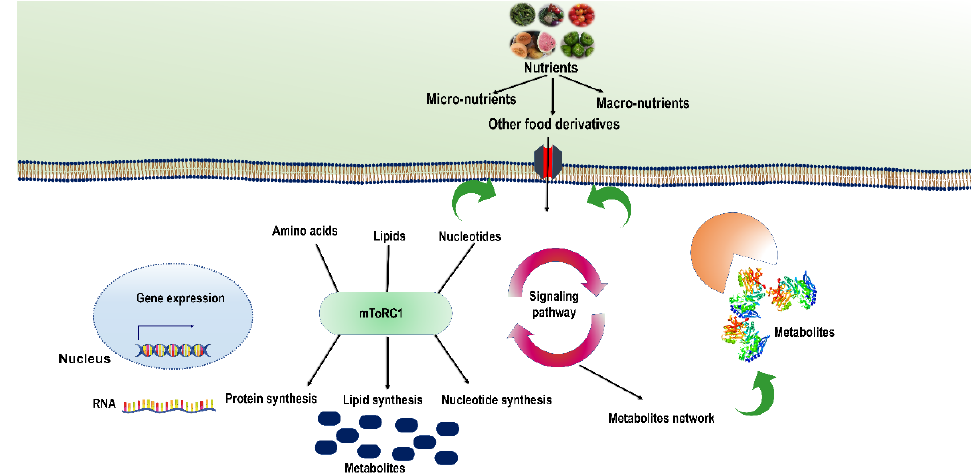
Figure 1. The main signalling pathways that regulate mTOR activity on the binding of micro- and macronutrients on their respective receptors on the cell membrane. Active mTOR plays the most vital role in cell growth and proliferation by stimulating diverse anabolic processes such as lipid synthesis, protein synthesis, and nucleotide